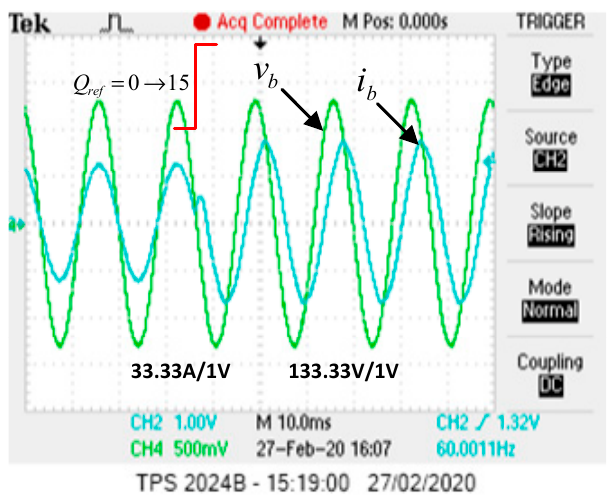
Figure 16. Voltage and current for phase B during Pref = 10 kW and transition from Qref = 0 to Qref = 15 kVar.